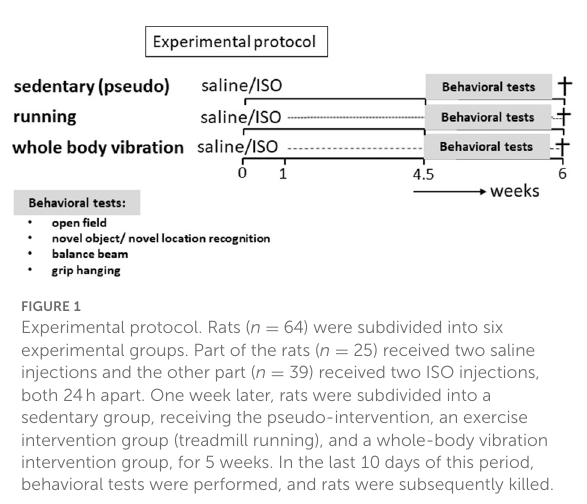
β -adrenoceptor agonist that mimics the histological, physical, and endocrinological events of human myocardial infarction